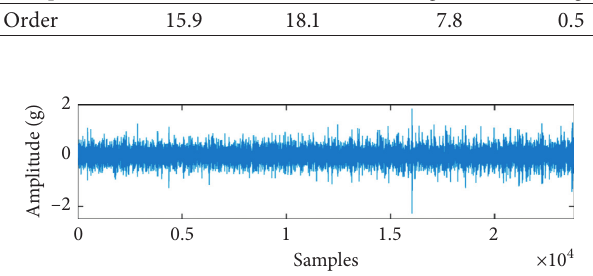
Table 4: Fault characteristic orders of 1# intershaft bearing. Component Outer race Inner race Rolling elements Cage